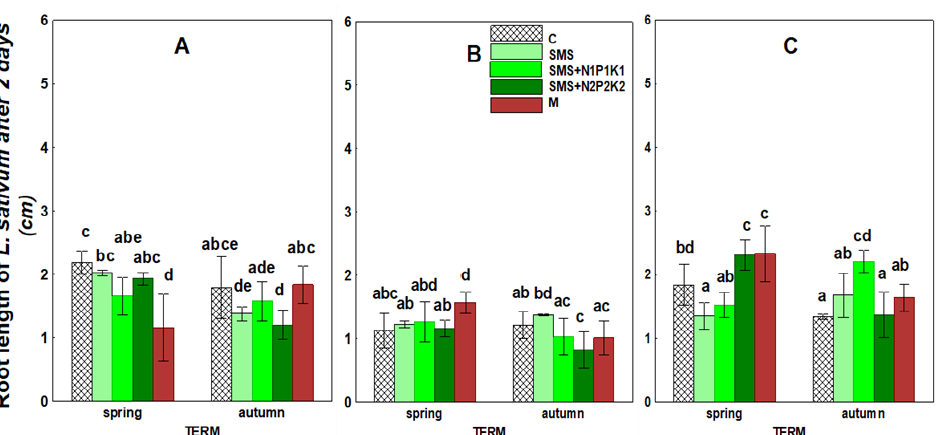
Figure 9. Increase in root length of Lepidium sativum in control soil and soil in different treatment strategies after two days. ( A ) — 1st year; ( B ) — 2nd year; ( C ) — 3rd year. C — control soil; SMS — soil + spent mushroom substrate; SMS + N1P1K1 — soil + spent mushroom substrate + mineral fertilization N1P1K1; SMS + N2P2K2 — soil + spent mushroom substrate + mineral fertilization N2P2K2; M — soil + manure. The vertical lines indicate the standard deviation. Different letters above the columns indicate significant differences at p < 0.05, and each year was analyzed independent of each other.